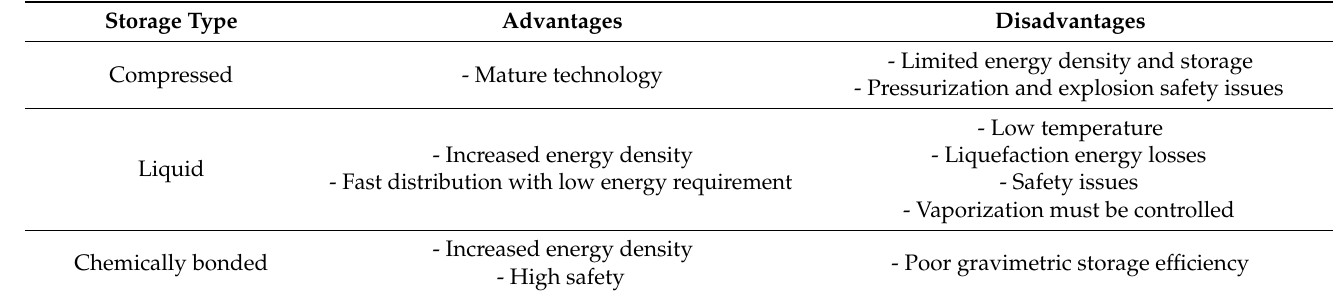
Table 5. Comparison of hydrogen storage